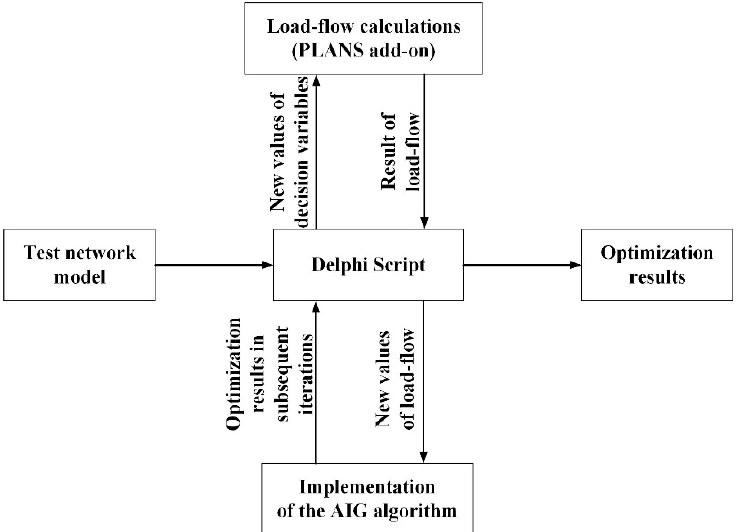
Figure 4. General scheme of the organisation of the computational process used in solving the optimisation task.